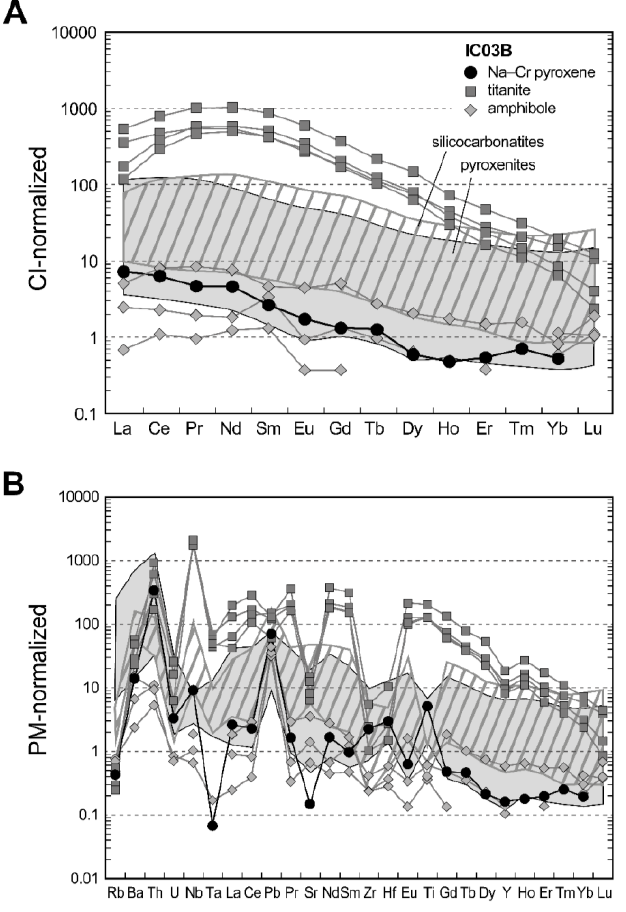
Figure 5. ( A ) Chondrite-normalized (Anders and Grevesse [28]) REE patterns of titanites, amphiboles and one Na–Cr-pyroxene grain from sample IC03B. Whole-rock data for the associated pyroxenites and silicocarbonatites [16] are also plotted; ( B ) Primitive mantle-normalized (McDonough and Sun [29]) multi-element concentrations in titanites, amphiboles and Na–Cr-pyroxene from IC03B. Both Na–Cr-rich pyroxene and titanite show similar features such as significant Nb–Ta fractionation and Sr depletion while Na–Cr-rich pyroxene shows extensive Pb enrichments and slight Zr–Hf enrichments (cf. Zr–Hf trough and Th enrichment in titanite). Ranges for host silicocarbonatites and pyroxenites [16] are also plotted for comparison.